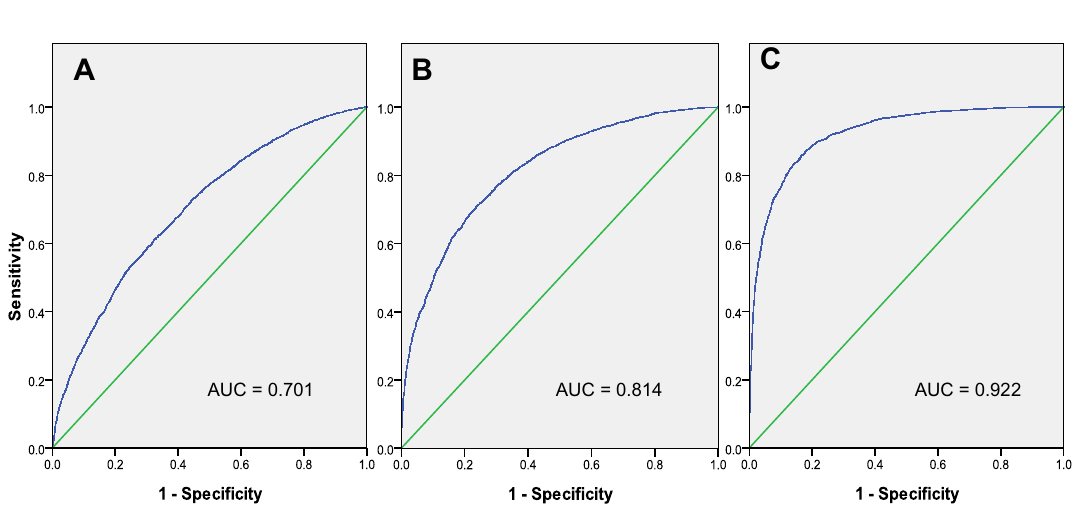
Figure 1. Receiver operating characteristic (ROC) analysis of simulated data in Model A ( A ), Model B ( B ) and Model C ( C